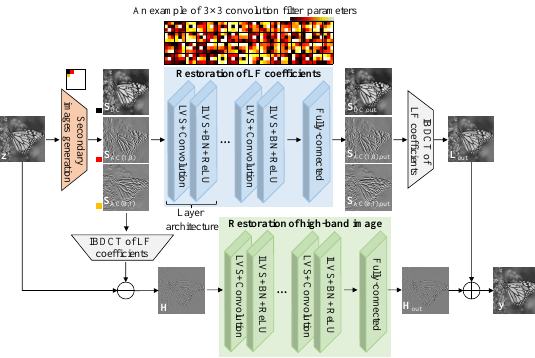
Figure 6. Architecture of the secondary domain intercorrelation enhanced network [4].